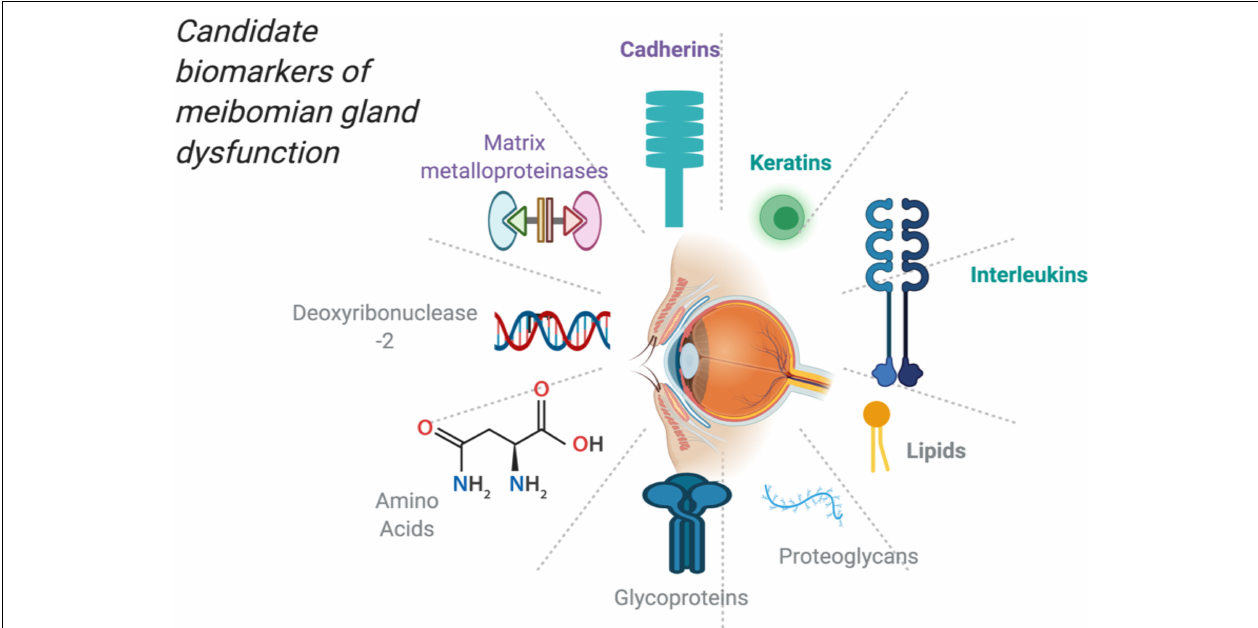
FIGURE 1 | Potential and candidate molecules as biomarkers for MGD created with publication license from BioRender.com.